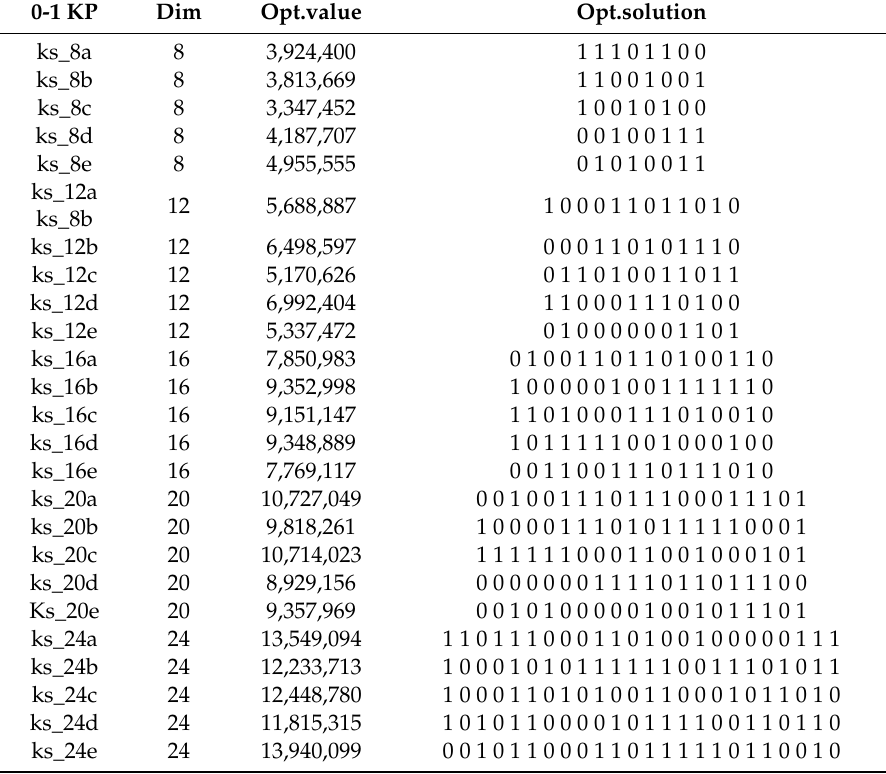
Table 6. The basic information of 25 low-dimensional 0-1KP